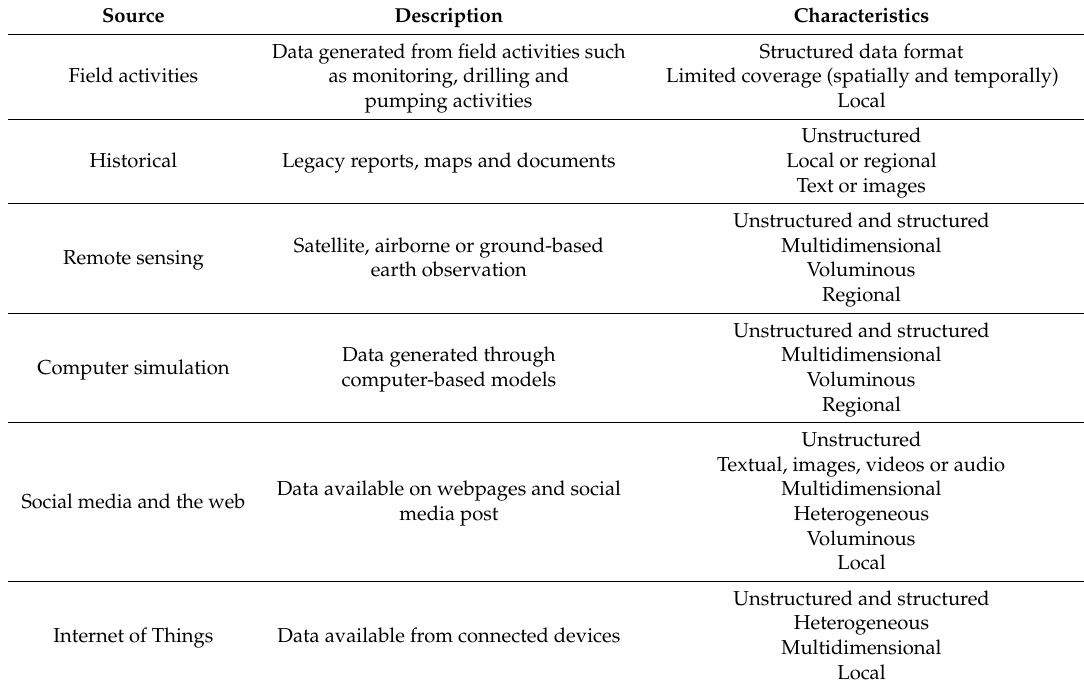
Table 1. Sources of data in the groundwater domain from a big data